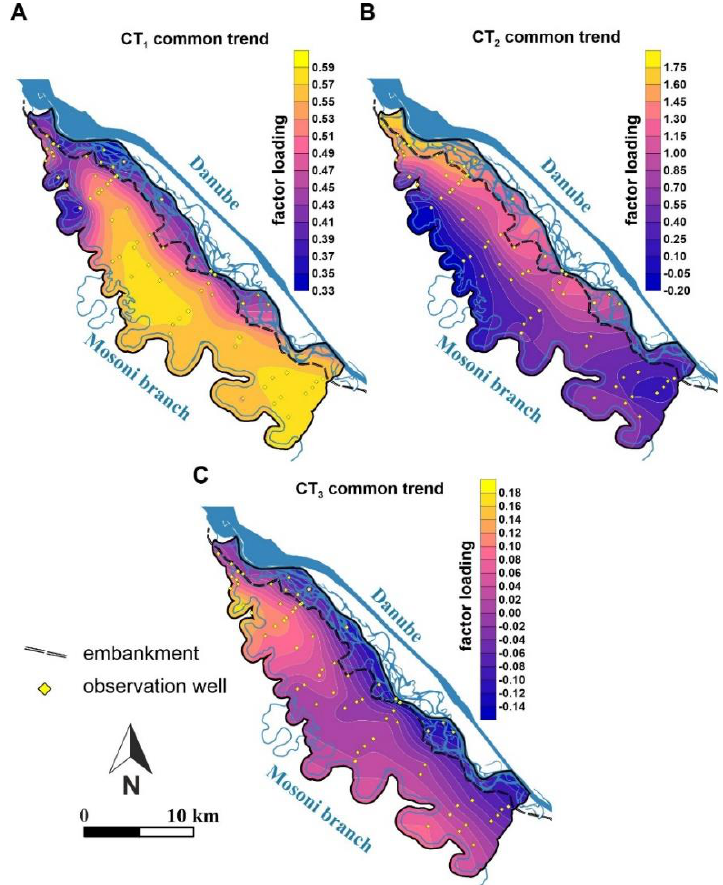
Figure 4. Spatial distribution of the loadings of common trends (CT 1 , CT 2 , and CT 3 ) determined for the investigated period.